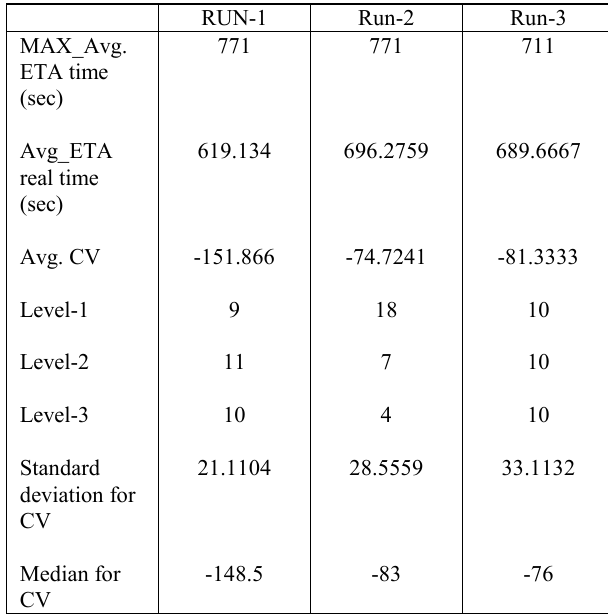
Table 2. Congestion value and level calculation For API data testing, data sampling for 3 hours a day, 1 hour